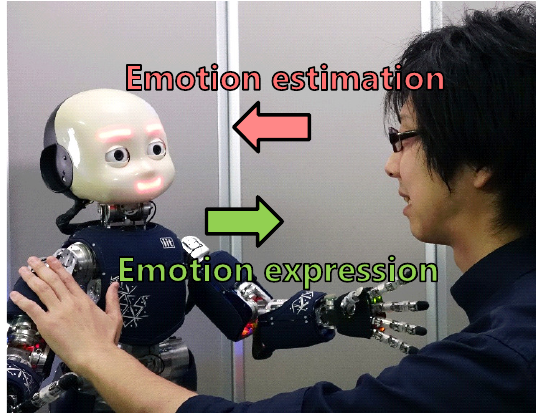
Figure 1: Overview of the assumed human–robot interaction. The red arrow represents emotional expressions of the partner and the green arrow represents emotional expressions of the